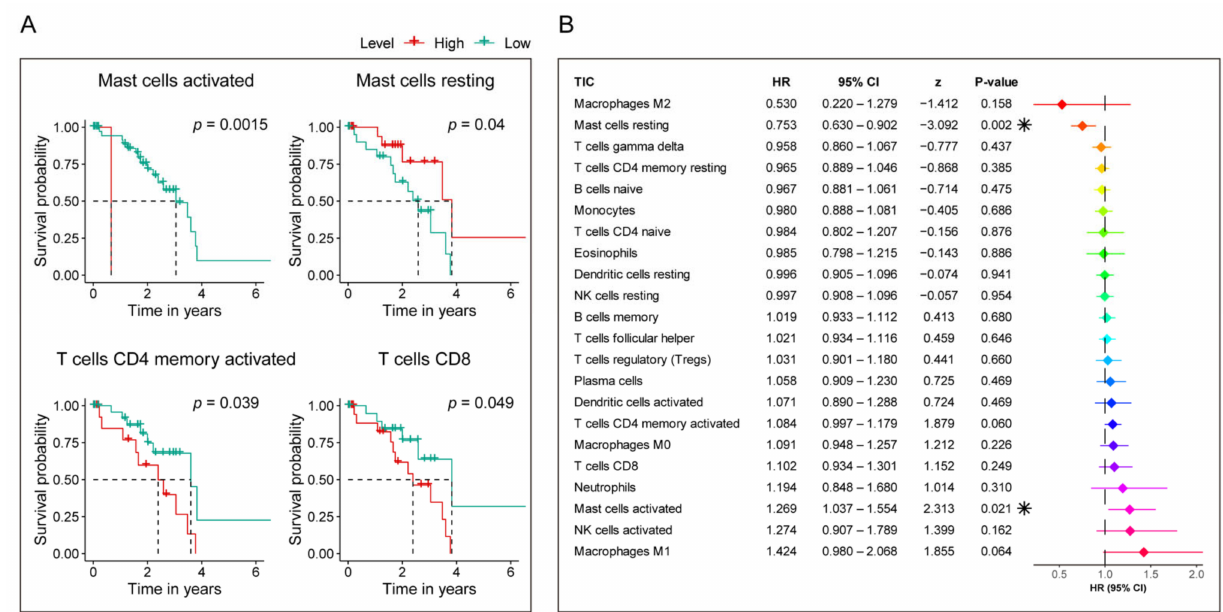
Figure 11. Evaluation of the prognostic ability of 22 TICs. ( A ) Kaplan–Meier survival curves of TICs that own prognosis value in UM. p -value < 0.05 in the log-rank test are set as the significant threshold. ( B ) Univariate Cox regression model built for 22 TICs based on overall survival. Asterix shown in the B plot indicate p -value is statistically